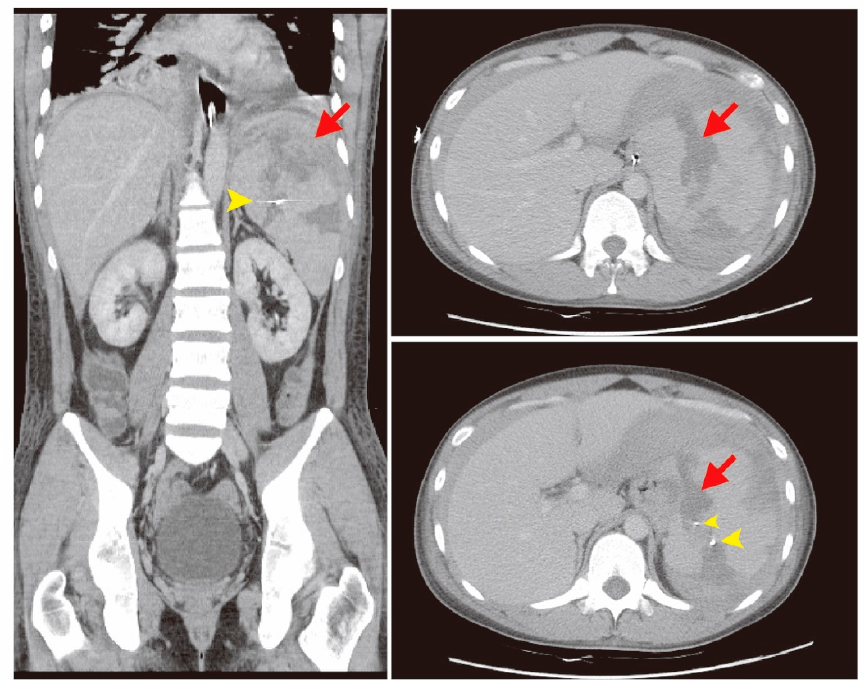
Figure 4. In the follow-up computed tomography (CT) scan, partial infarct of the spleen (red arrows) with two-coil embolization was noted, with improved hemoperitoneum (yellow arrow heads).